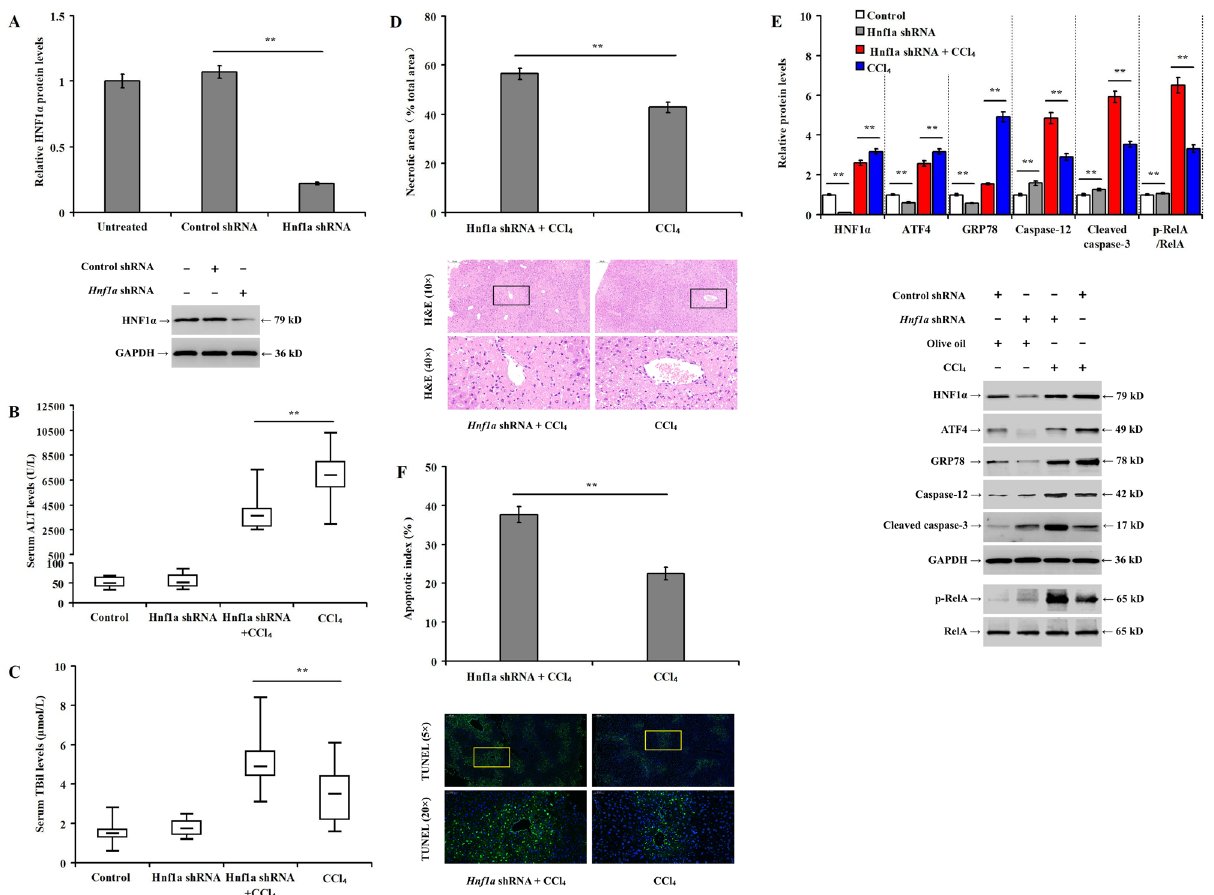
Figure 6. Knockdown of Hnf1a aggravates CCl 4 -induced liver injury, hepatocyte apoptosis, and ER stress in mice: ( A ) bar chart and western blotting showing the alteration in HNF1α expression in the untreated, or treated with control shRNA, or Hnf1a shRNA groups; ( B ) impact of Hnf1a knockdown on serum ALT levels in mice model of liver injury induced by CCl 4 ; ( C ) impact of Hnf1a knockdown on serum TBil levels; ( D ) bar chart showing the proportion of necrotic liver tissue area and histopathological changes in mouse liver in the different experimental groups; ( E ) bar chart representing the relative protein expression and representative western blotting for the different experimental groups; and ( F ) hepatocyte apoptotic index measured by TUNEL staining. ** p < 0.01 versus control (control shRNA, or control shRNA + olive oil) or CCl 4 group (control shRNA + CCl 4